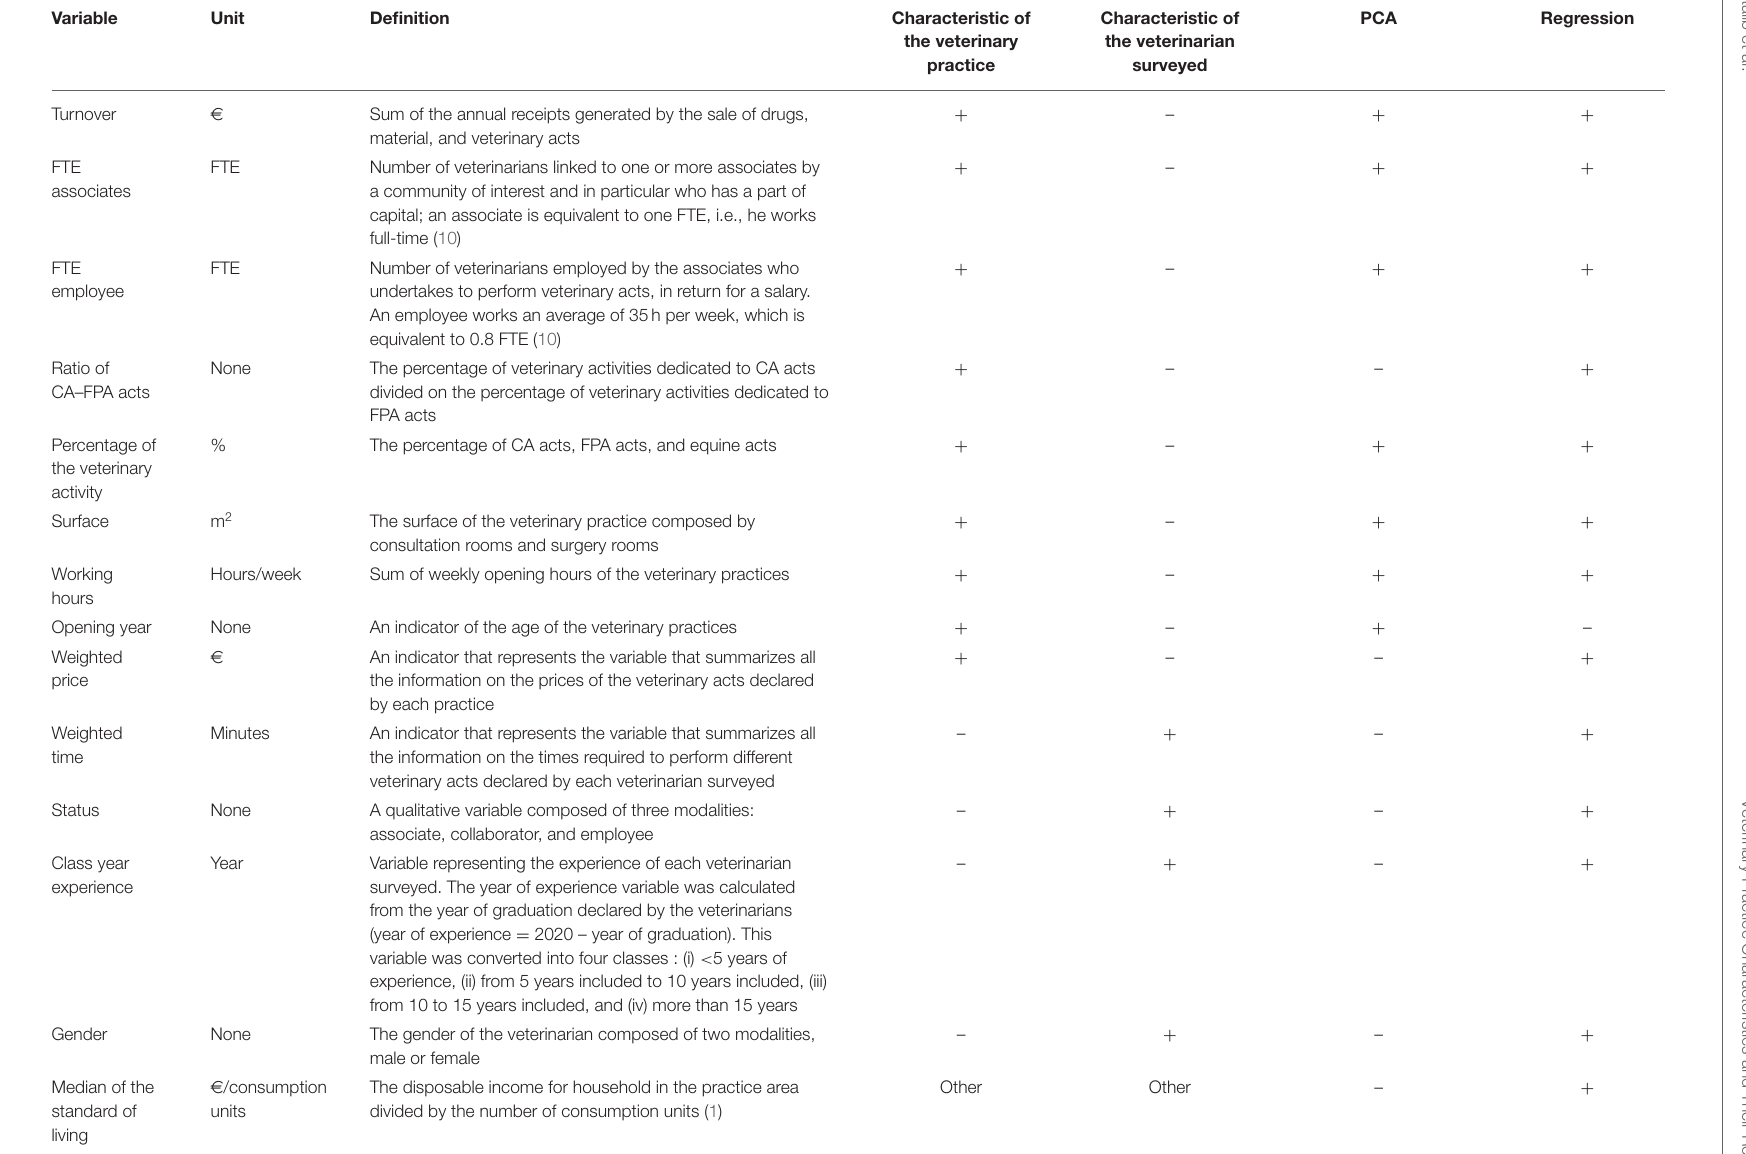
TABLE 1 | Definition of variables characteristic of veterinary practices and characteristic of veterinarians used in statistical analysis.